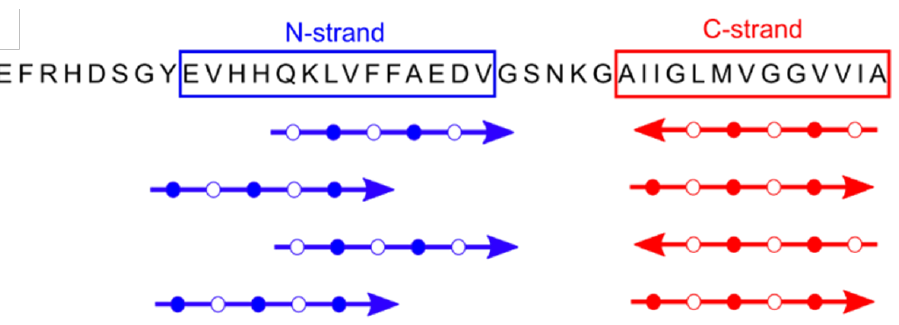
Figure 3. The primary and secondary structure of 150-kDa oligomers of A β 42 (from data in [30]). Shown in blue and red are the β -strands detected by 2D NMR and the parallel or antiparallel organization of each β -strand. In addition, the registry shift within the N-strand β -sheet is likely to be three residues and alternate in direction (±3).